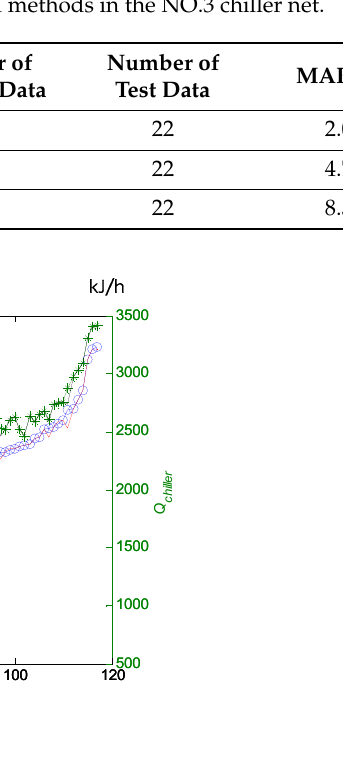
Table 2. Performance comparison with various control methods in the NO.3 chiller net.